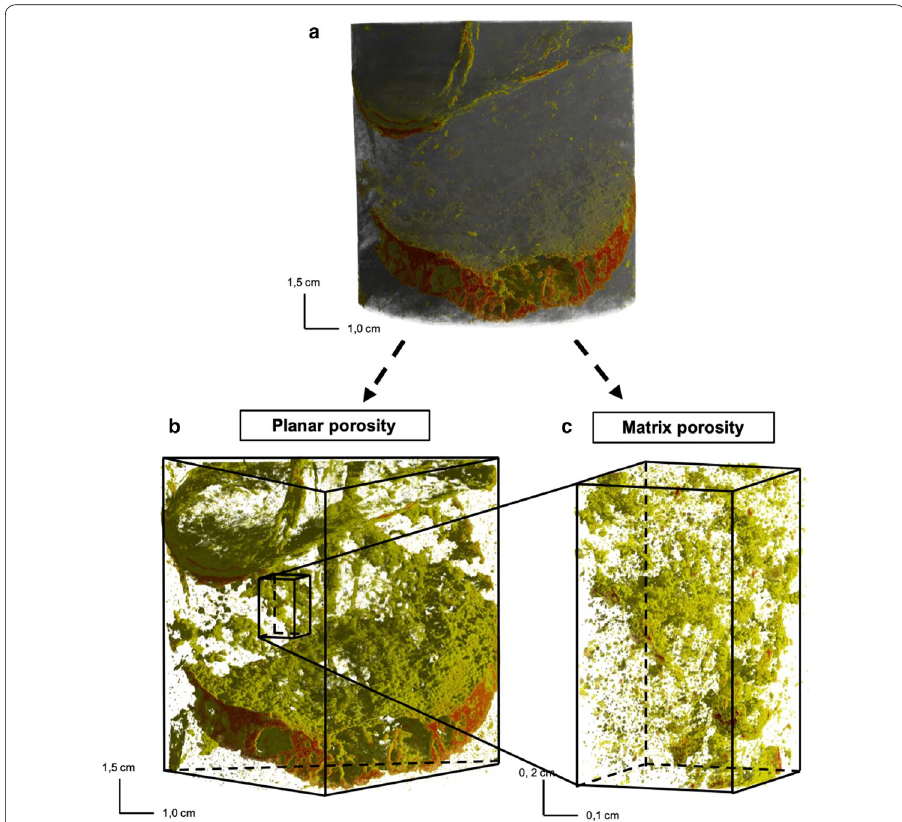
Fig. 9 Three‑dimensional observations of the planar and matrix porosity of one sample taken from the Pontgibaud fault zone. The red color of figures a , b corresponds to mineralization (lead sulphides). The yellow color of figures a , b corresponds to the planar porosity located on the fracture walls. The yellow color of figure c could correspond to the matrix porosity. The resolution of figures a – c is, respectively, 25, 25 and 4